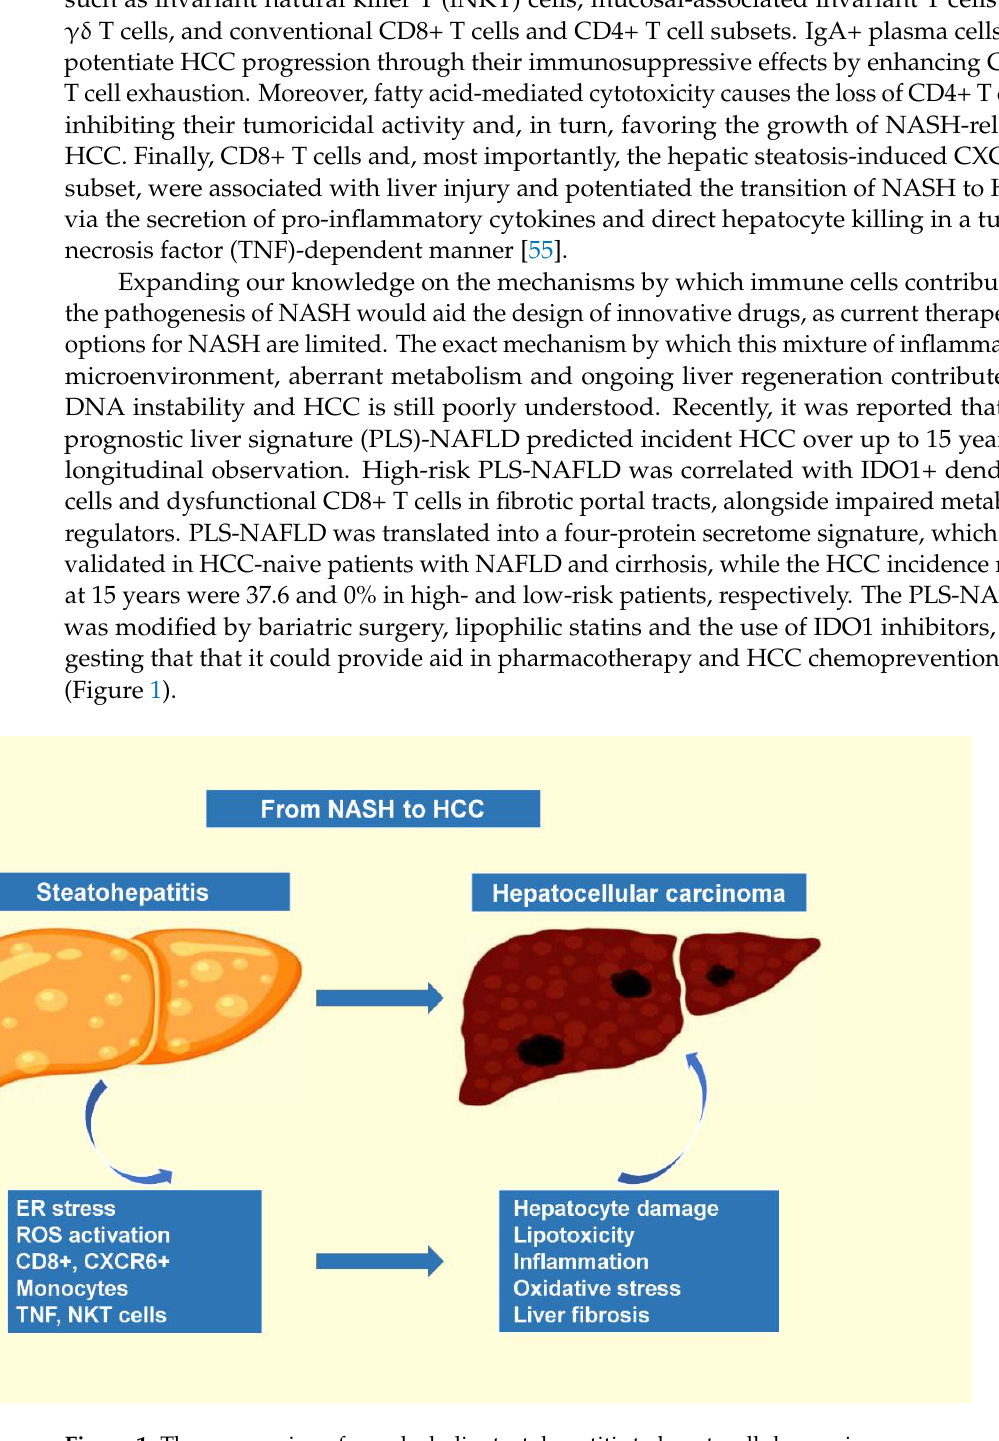
Figure 1. The progression of nonalcoholic steatohepatitis to hepatocellular carcinoma.